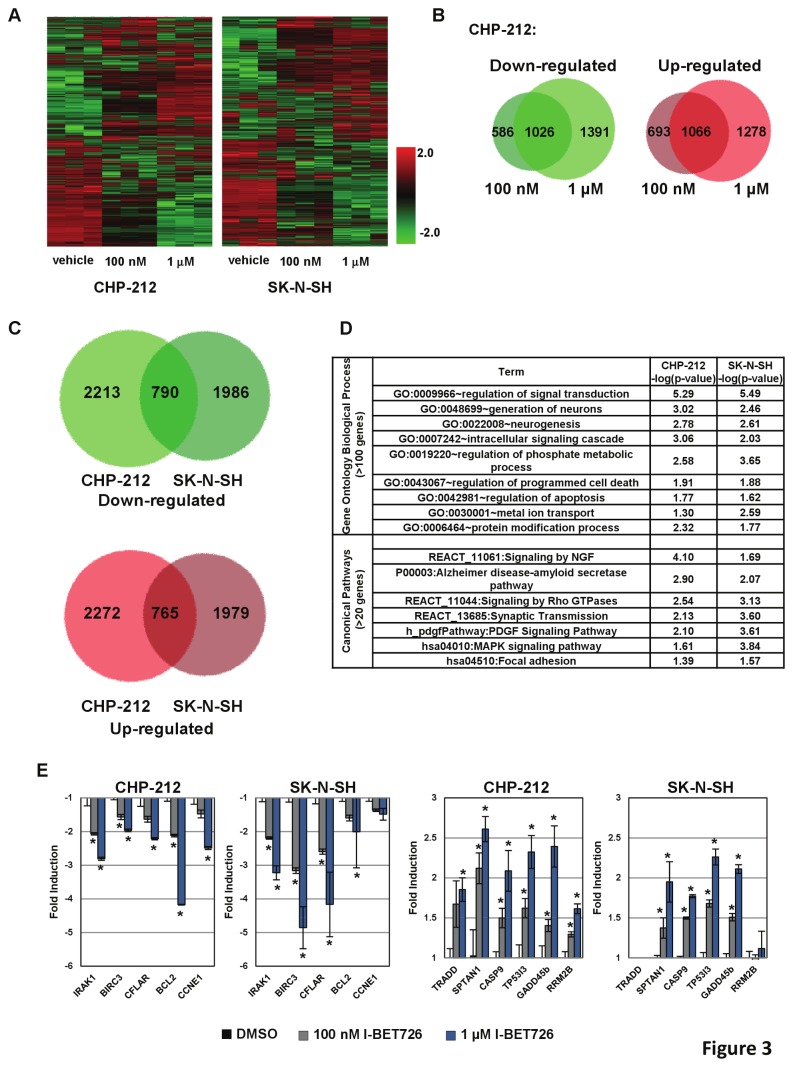
Global transcript profiling in neuroblastoma cell lines treated with I-BET726 reveals gene expression changes in apoptotic and signaling pathways.(a) Hierarchical clustering of statistically significant probes that were differentially expressed in 100 nM or 1 µM treatments of I-BET726 relative to vehicle in CHP-212 and SK–N–SH. (b) Venn analysis for up-regulated and down-regulated probes described in (a) in the CHP-212 cell line. (c) Venn analysis for overlap of up-regulated and down-regulated probes in the SK–N–SH and CHP-212 cell lines. (d) Functional analyses of expression changes were performed by GO and canonical pathway enrichment at the gene level. A subset of statistically significant categories for GO Biological Process (>100 genes) and canonical pathways (>20 genes) from KEGG and BioCarta that were common among the two cell lines are shown. (e) qRT-PCR confirmation of a subset of genes selected from the functional analyses described in (d). Data represent mean value ± standard deviation for three independent biological replicates. Asterisks indicate statistical significance as measured by t-test (p <0.05).